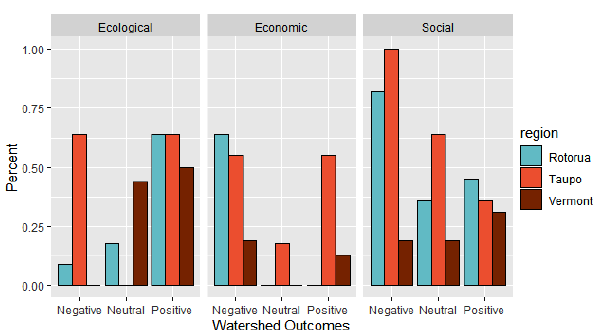
Fig. 6 . Percentage watershed outcomes by